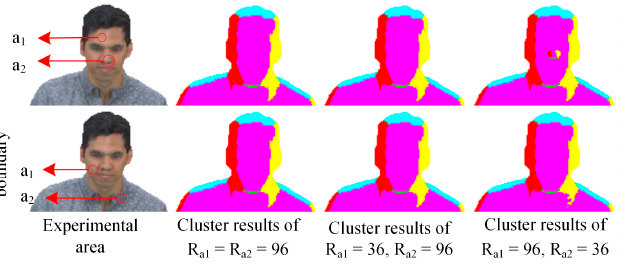
Figure 5. The clustering results obtained by searching with various radii in a specific area (a1 is a low-curvature area, while a2 is a high-curvature area). low-curvature area, while a2 is a high-curvature area).